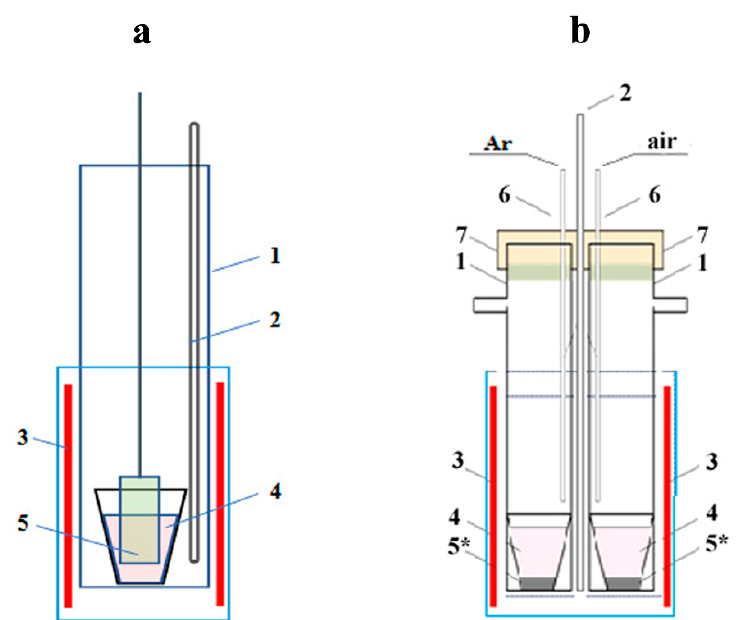
Figure 3. Design of the reactors for the modifying chemical composition of single crystalline ( a ) and powder ( b ) lithium niobate in salt melts: (1) quartz tube, (2) thermocouple, (3) electrical furnace, (4) salt melt, (5) single crystalline plate, (5*) LiNbO 3 powder, (6) tube for gas supply, (7) stopper.